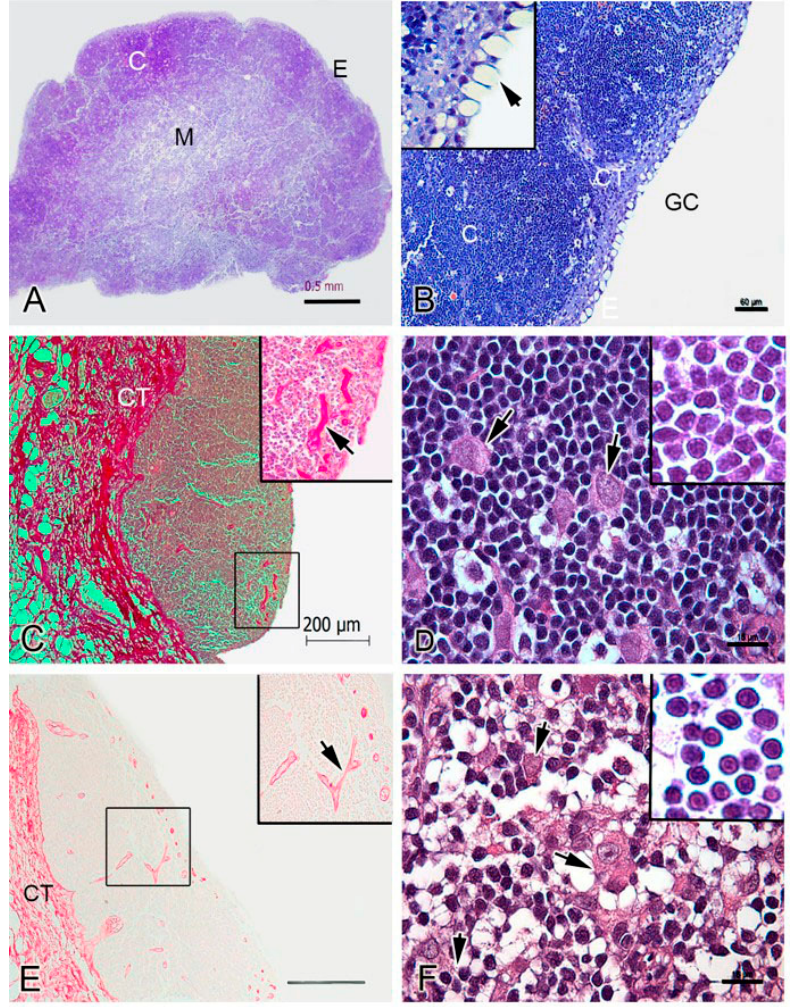
Figure 2. Histological organization of the thymus in rainbow trout. ( A ). Thymus section of rainbow trout. Epithelium (E), cortex (C) and medulla (M) are shown. ( B ). High magnification of E and C. Gill cavity is indicated (GC). Thymus parenchyma is divided by connective tissue (CT, trabeculae). The inset shows the single layer of epithelium (E) with mucous-like cells arrow). ( C ). Shows a broad distribution of collagen (in red) in the CT. The inset shows blood vessels are positive for picrosirius staining (arrow). ( D ). High magnification of the C showing thymocytes and larger cells (15 µm diameter approximate, arrows). The inset shows thymocytes with a central spherical nucleus and scant cytoplasm. ( E ). Shows a broad distribution of elastic fibers in the CT (in brownish red). The inset shows blood vessels are positive for orcein staining (arrow). ( F ). High magnification of the M showing large cells (arrows); thymocytes (inset) with a similar morphology to those in the C. A, B, D and F—Giemsa histochemical staining. ( C )—Picrosirius histochemical staining. ( E )—Orcein histochemical staining. Note the distinction between the cortex (dark staining) and the medulla (pale staining).